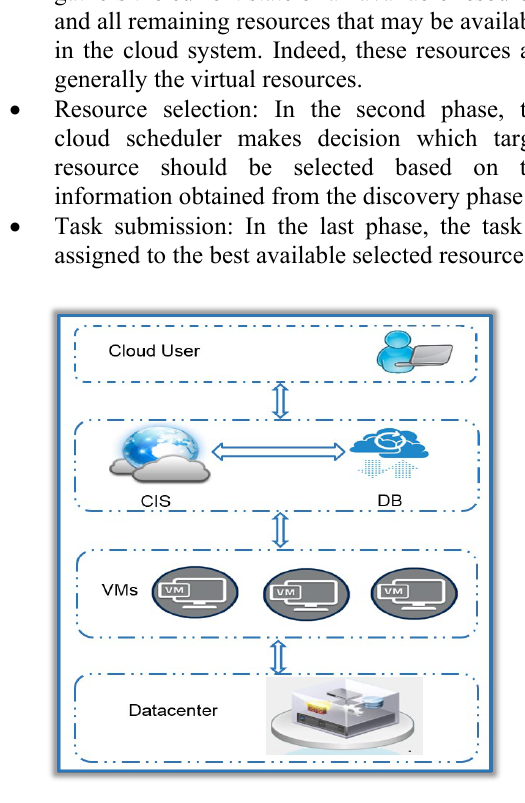
Figure 1. Procedure of scheduling in cloud Datacenter